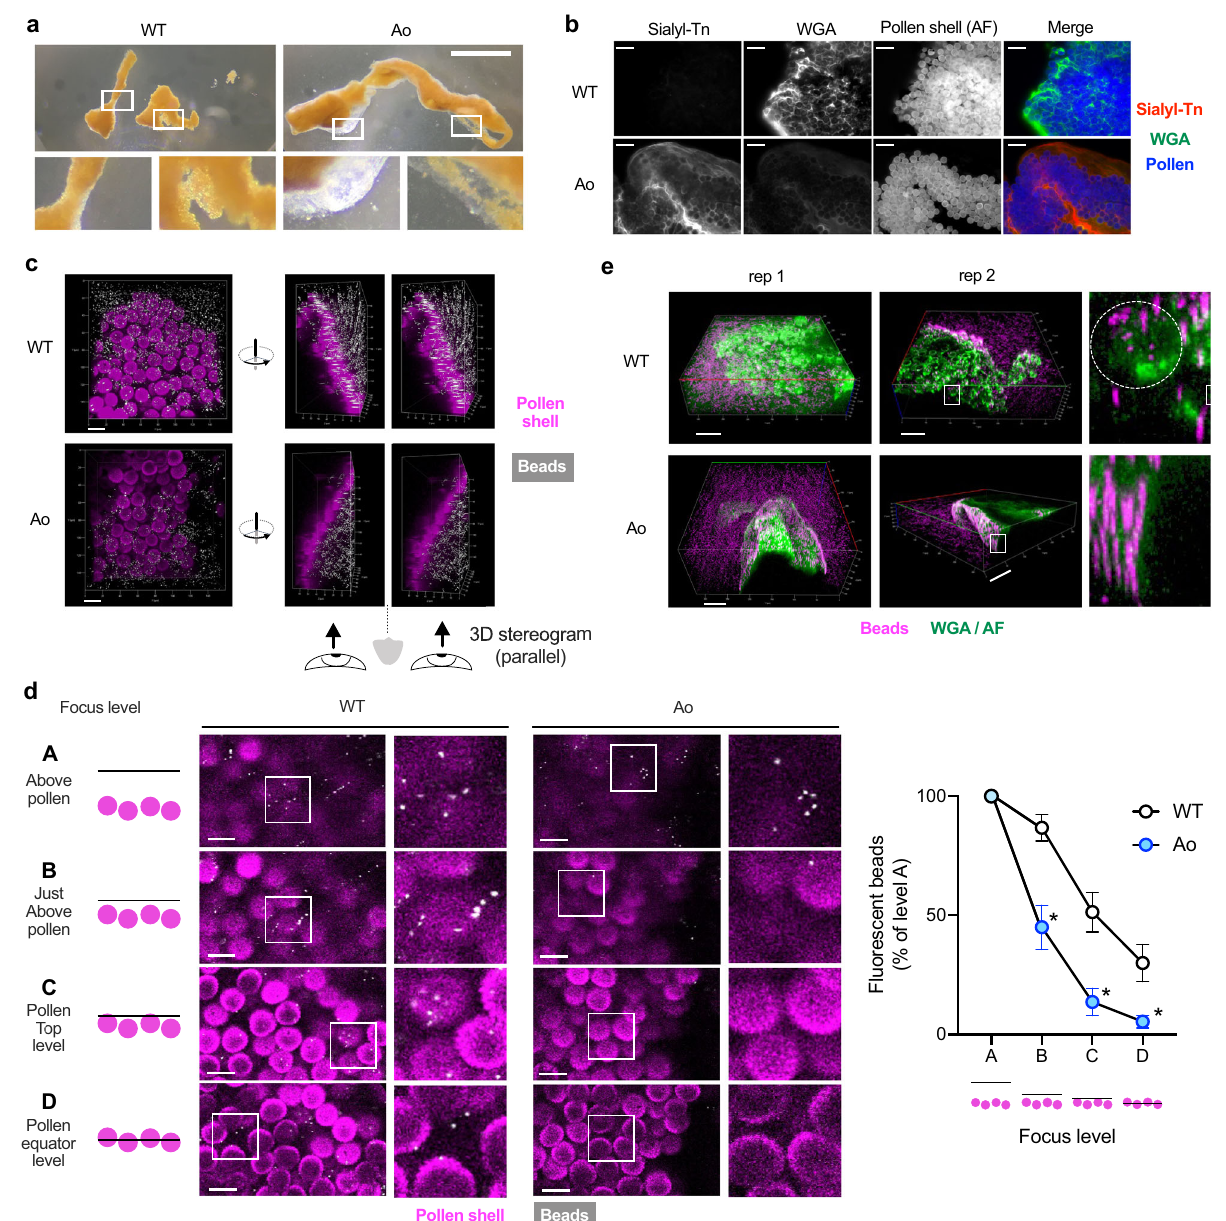
Fig. 5 | Sialylated mucins encapsulate pollens with an impenetrable layer. a Representative pictures of pollen shell-mucus aggregates 25min after challenge. Bar,1mm. See also Supplementary Fig. 5 for more examples. b Immunostaining of pollen shell aggregates retrieved from the conjunctival sac. AF, auto fl uorescence. Bar, 50 μ m. c The pollen shell aggregates from indicated strain were soaked in the fl uorescent beads-suspended PBS. Parallel-view 3D stereogram of the side-view is also shown. Bar, 20 μ m along the closest edge. d The bead distribution was enumerated atvarious focus levels. Bar,20 μ m. n =6 for WT and n =7 for Ao mice. * p <0.05 (adjusted p =0.0101, 0.0101, and 0.0233 for levels B, C, and D) by two-